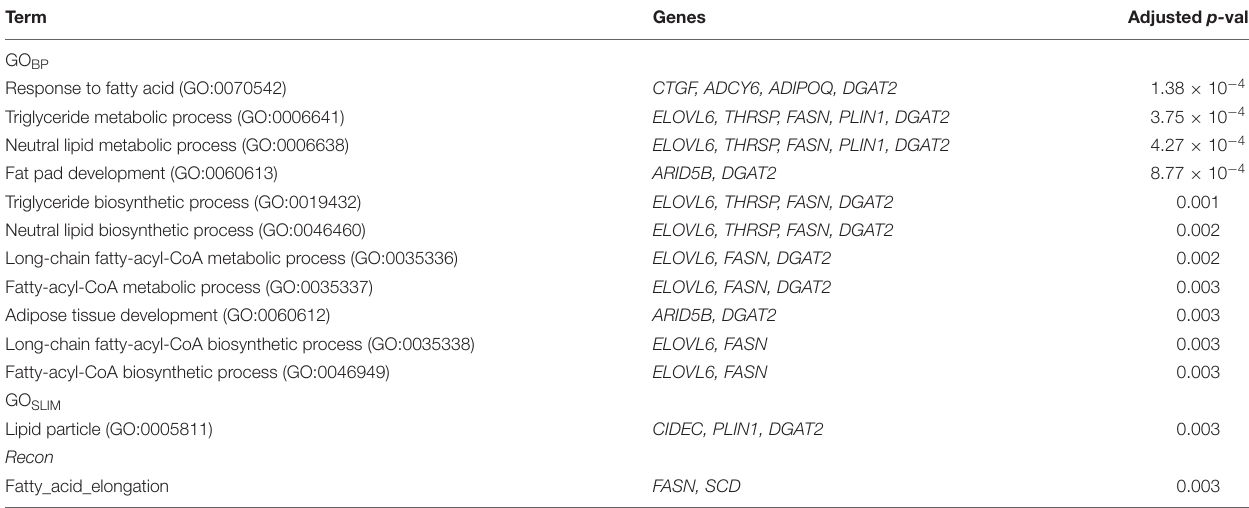
TABLE 3 | Summary of significantly overrepresented pathways related with lipid metabolism in the DE genes between H and L groups. Term